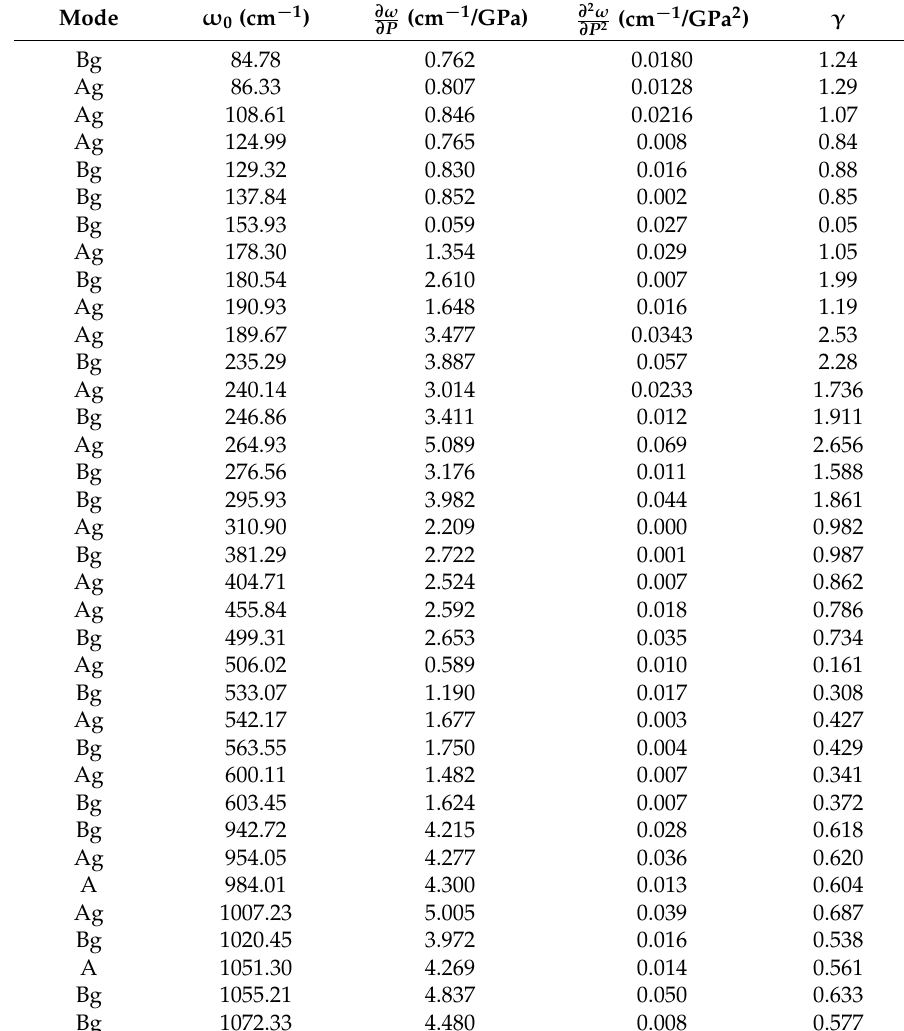
Table 6. Raman frequencies at ambient pressure, their pressure coefficients, and Grüneisen parameters ( γ ). The pressure dependence of frequency has been fitted with a second order